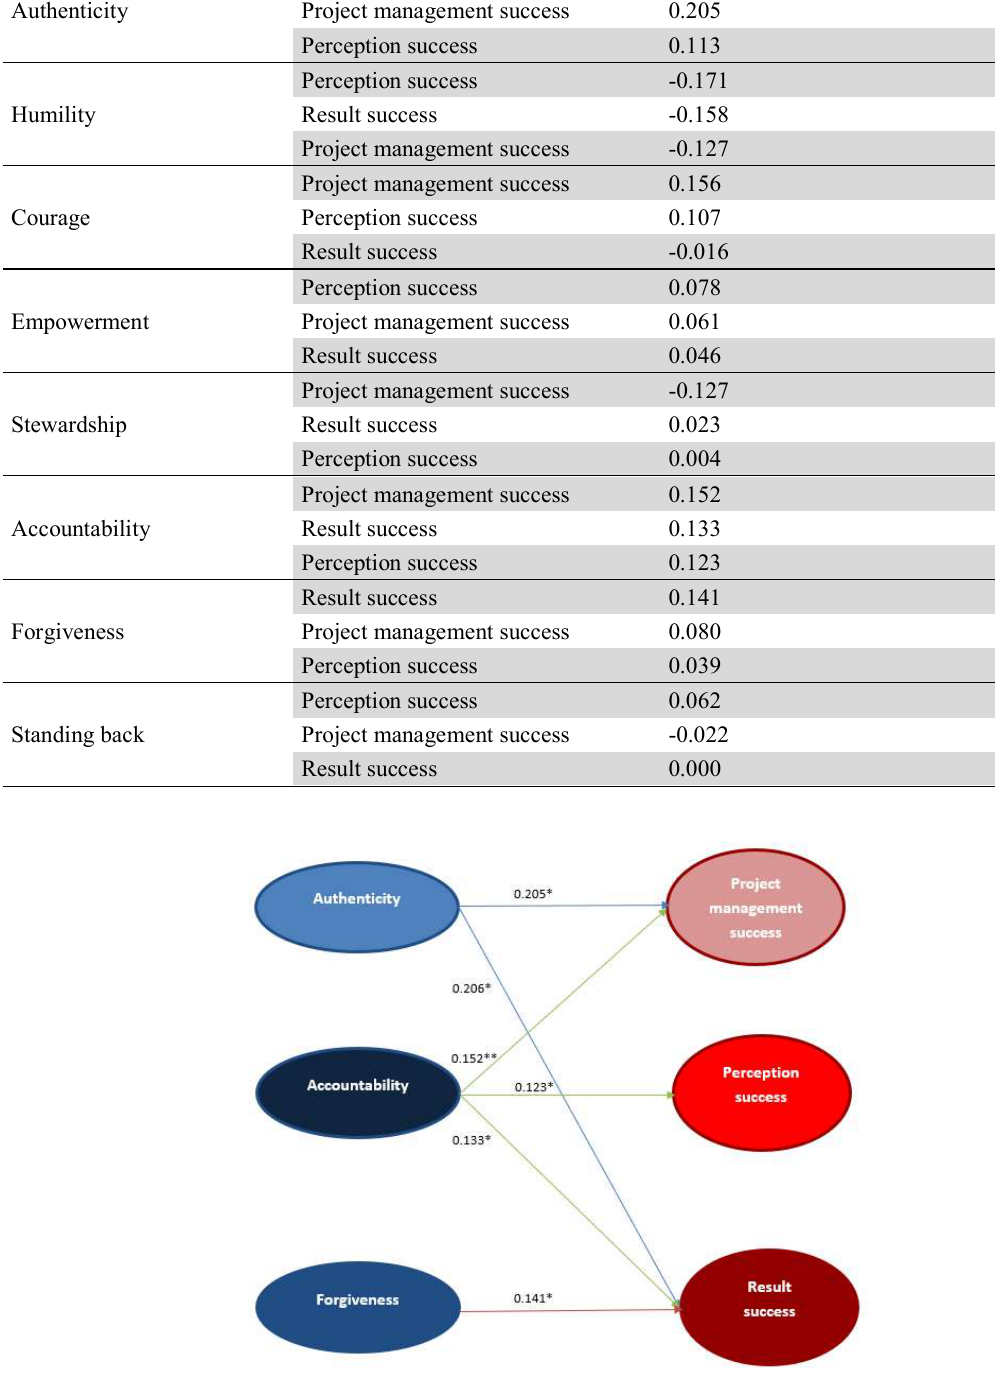
Fig. 1. Impacts of Servant